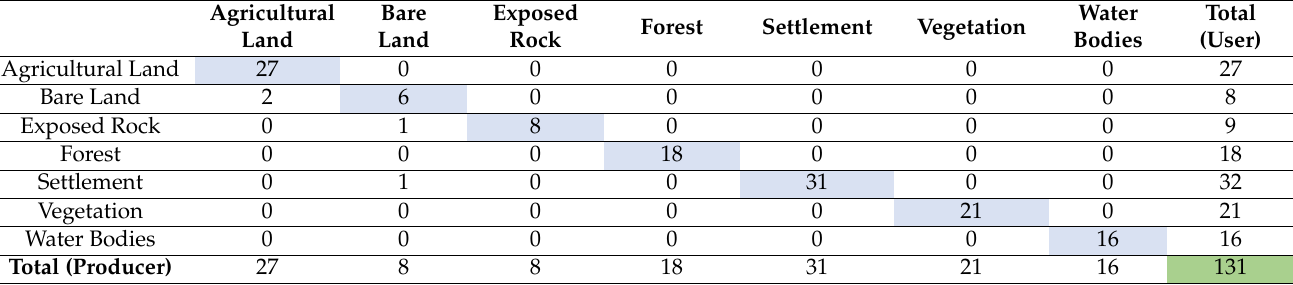
Table A8. Accuracy assessment table of 2021 LU/LC classification.